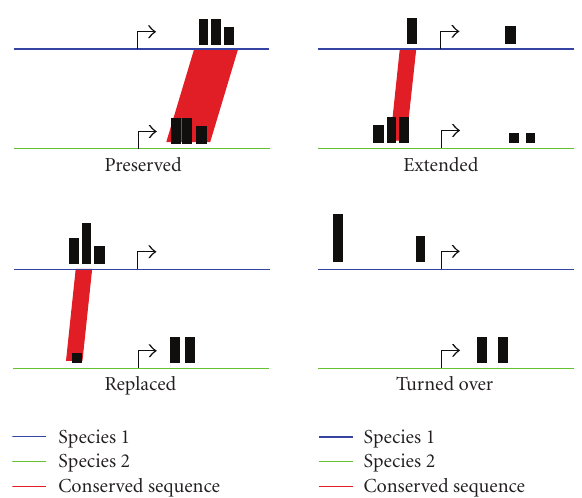
Figure 2: Possible evolutionary changes to PPRE location, strength, and conservation. Hypothetical genes from two di ff erent species (e.g., human and mouse) were compared for their PPREs (black bars, their height indicates relative strength). When the PPRE pattern is preserved, the genes will be sorted into cluster I, when extended in cluster II, when replaced in cluster III and when not at all conserved (e.g., when turned-over) in cluster